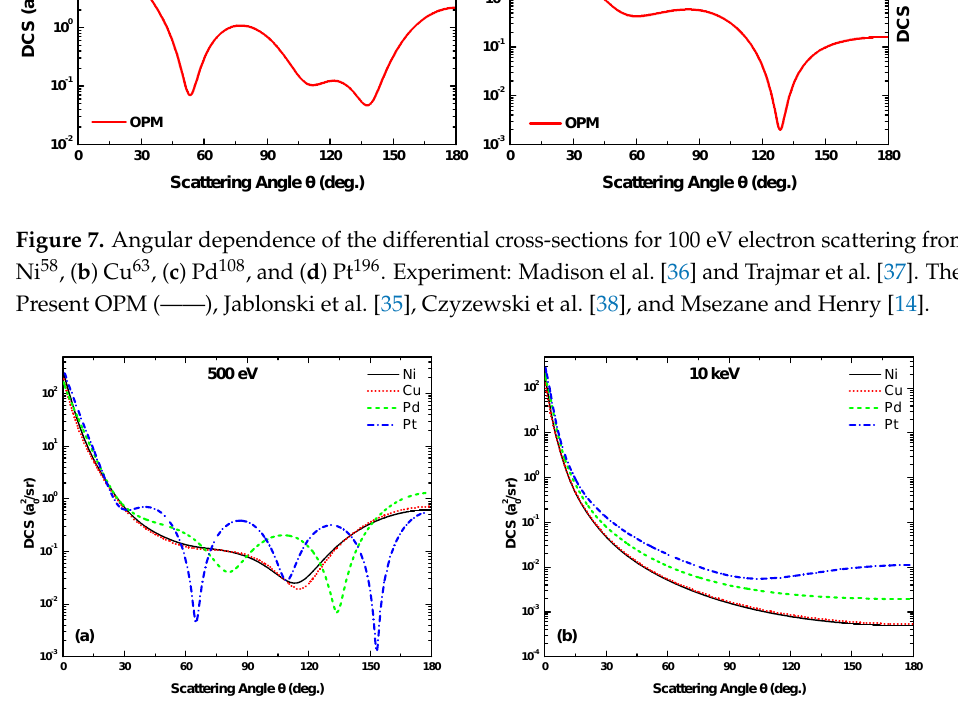
Figure 8. Angular dependence of the differential cross-sections due to the OPM approach for electron scattering from Ni 58 , Cu 63 , Pd 108 , and Pt 196 at impact energies of ( a ) 500 eV and ( b ) 10